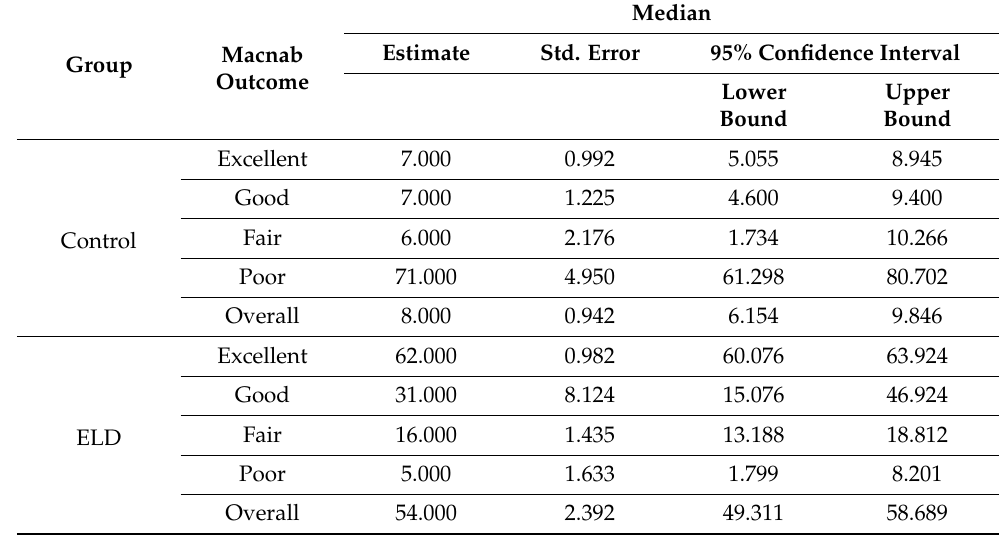
Table 6. Medians for survival time by Macnab outcome estimating the durability of the targeted lumbar decompression of visualized painful pathology based on SpineScreen (ELD) versus MRI-based laminectomy and